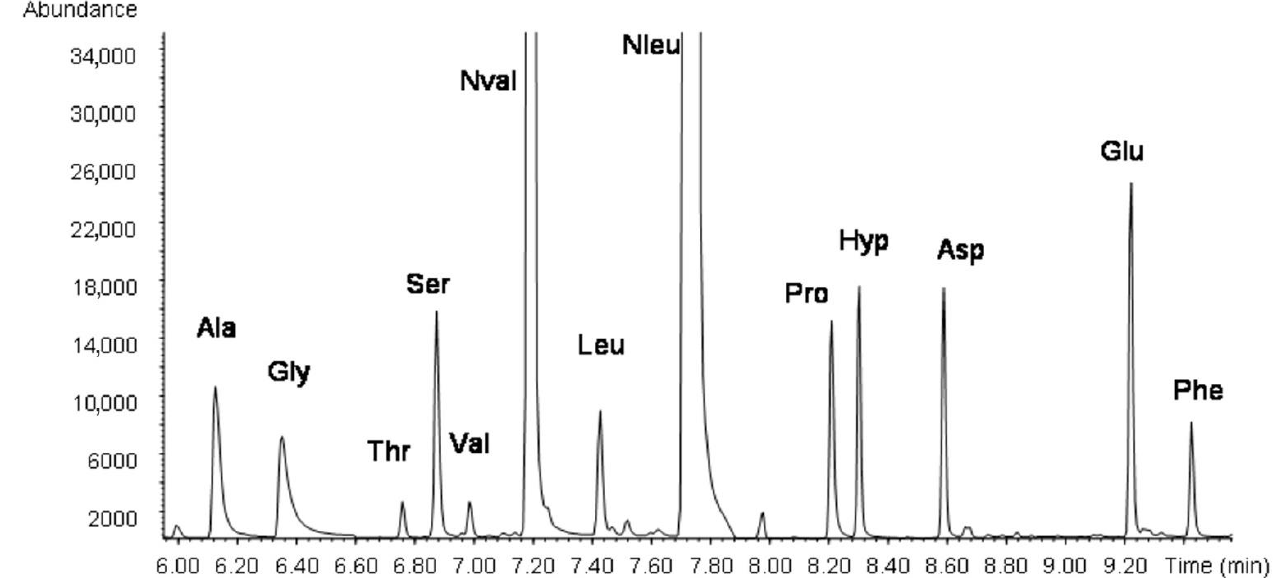
Figure 10. GC-MS chromatogram of the proteinaceous fraction of B7 sample (green sample taken from the meadow under the horse of St. Paul). Ala = alanine, Gly = glicine, Thr = threonine, Ser = serine, Val = valine, Nval = norvaline (internal standard), Leu = leucine, Nleu = norleucine (internal standard), Pro = proline, Hyp = hydroxyproline, Asp = aspartic acid, Glu = glutamic acid, Phe = phenylalanine.